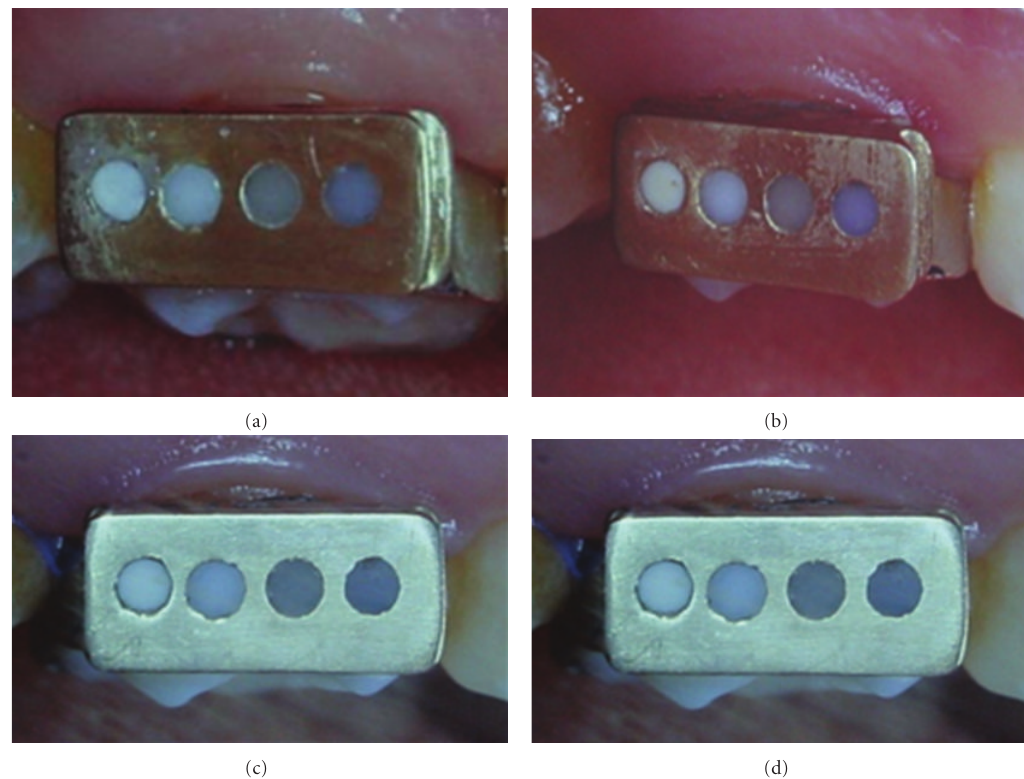
Figure 1: Cement holder (a) at baseline; (b) after 6 months; (c) after 12 months; and (d) after 18 months. Cements were placed in uniform cylindrical openings. In sequence from left to right are zinc phosphate, glass ionomer, resin-modified glass ionomer, and resin